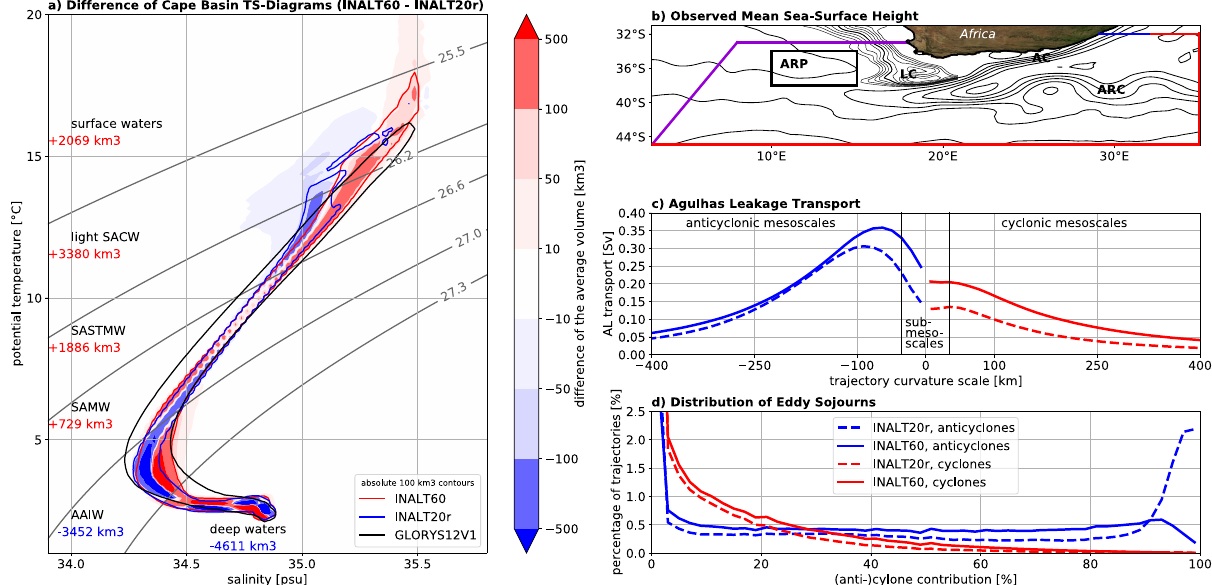
Fig. 2 Submesoscale fl ows salinify the ring path waters, enhance Agulhas leakage, in particular by strengthening non-anticyclonic leakage pathways, and lead to a stronger exchange of Agulhas rings with their surrounding. a Colours show the difference of INALT60 and INALT20r in the mean water volume associated with speci fi c temperature-salinity properties in the upper 2500 m of the ring path (black box in b )) for the period 2012 – 2017. Red, blue and black lines show the respective absolute 100 km 3 contours for INALT60, INALT20r and the reanalysis product GLORYS12V1 22 . Grey contours show potential density contours that de fi ne the water-masses of surface waters, light South Atlantic Central Water (SACW), South Atlantic Subtropical Mode Water (SASTMW), South Atlantic Mode Water (SAMW), Antarctic Intermediate Water (AAIW) and deep waters 50 . For each water-mass the sum over the difference of the respective volumes is given. b The 2012 – 2017 mean sea-surface height from the L4 CMEMS satellite altimetry product with a contour interval of 20 cm and southwest of Africa of 2 cm for the interval – 30 cm to – 10 cm to highlight the location of the time-mean lee cyclone (LC), the Agulhas Current (AC), the Agulhas Return Current (ARC) and the Agulhas Ring Path (ARP). Vsirtual Lagrangian particles are seeded within the AC at 32 ∘ S (blue) and contribute to Agulhas leakage if they reach the Good Hope Line (violet). The trajectories are also terminated, if they reach the red lines. For land areas a satellite picture is shown 49 . c The average Agulhas leakage transport decomposed into its contributions from trajectory curvature scales between 20 ∘ E and the Good Hope Line. d The distribution of the fraction of (anti-) cyclonic eddy sojourns for the leakage trajectories in the same region. c and d join the same